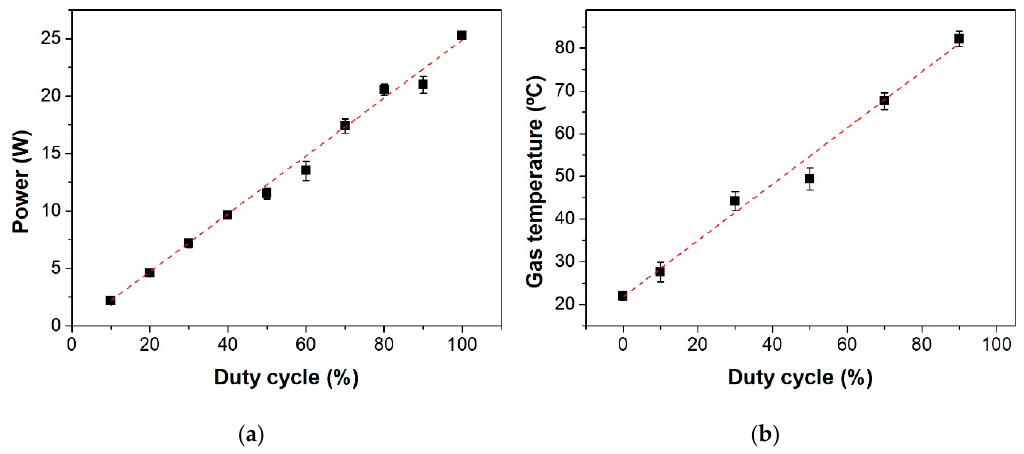
Figure 9. ( a ) Discharge power increase and ( b ) linear rise of gas temperature with voltage duty cycle variation for the argon discharge after 4 min from starting the plasma.